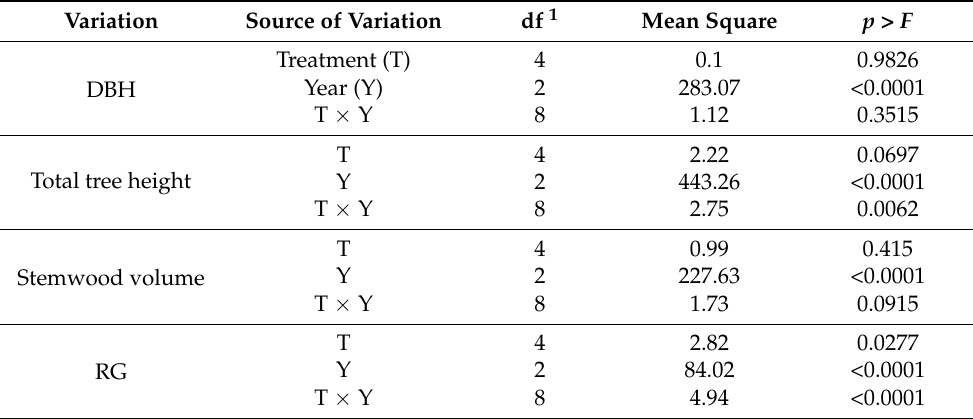
Table 1. Probabilities of a greater F- value ( p > F ) from two-way analyses of variance of diameter at breast height (DBH), total tree height, stemwood volume, and relative stem radial growth (RG) 34 months following stem inoculation of P. taeda trees with L. terebrantis near Eufaula, AL, USA.